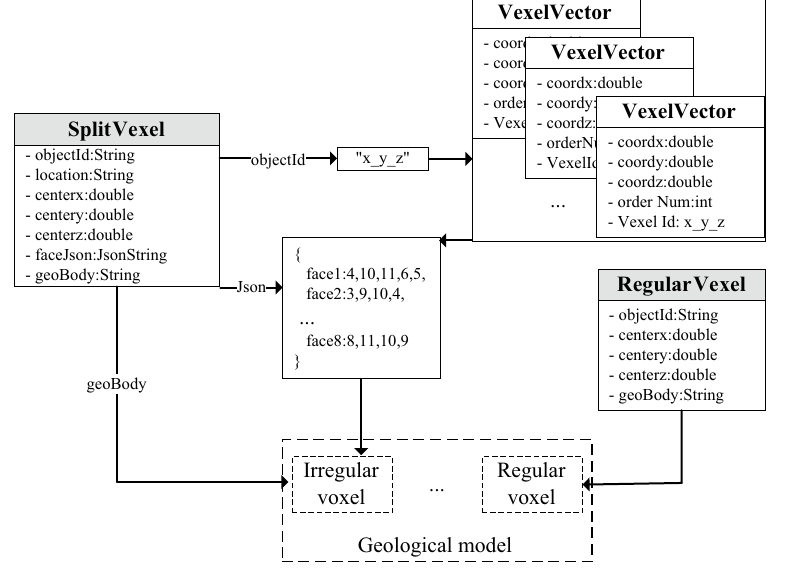
Figure 11. Data analysis